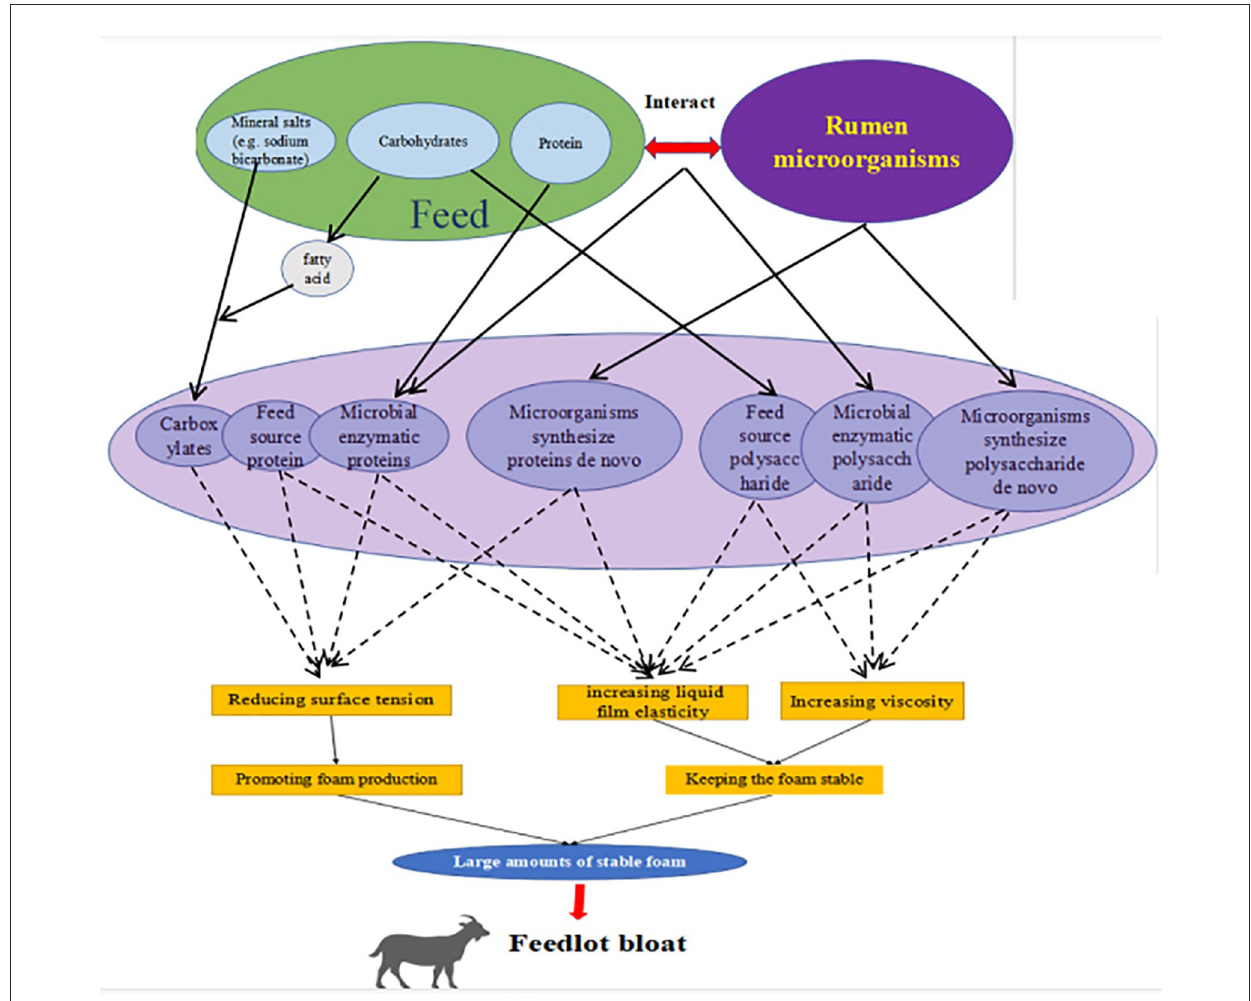
FIGURE3 Speculative diagram of the mechanism for high-concentrate type